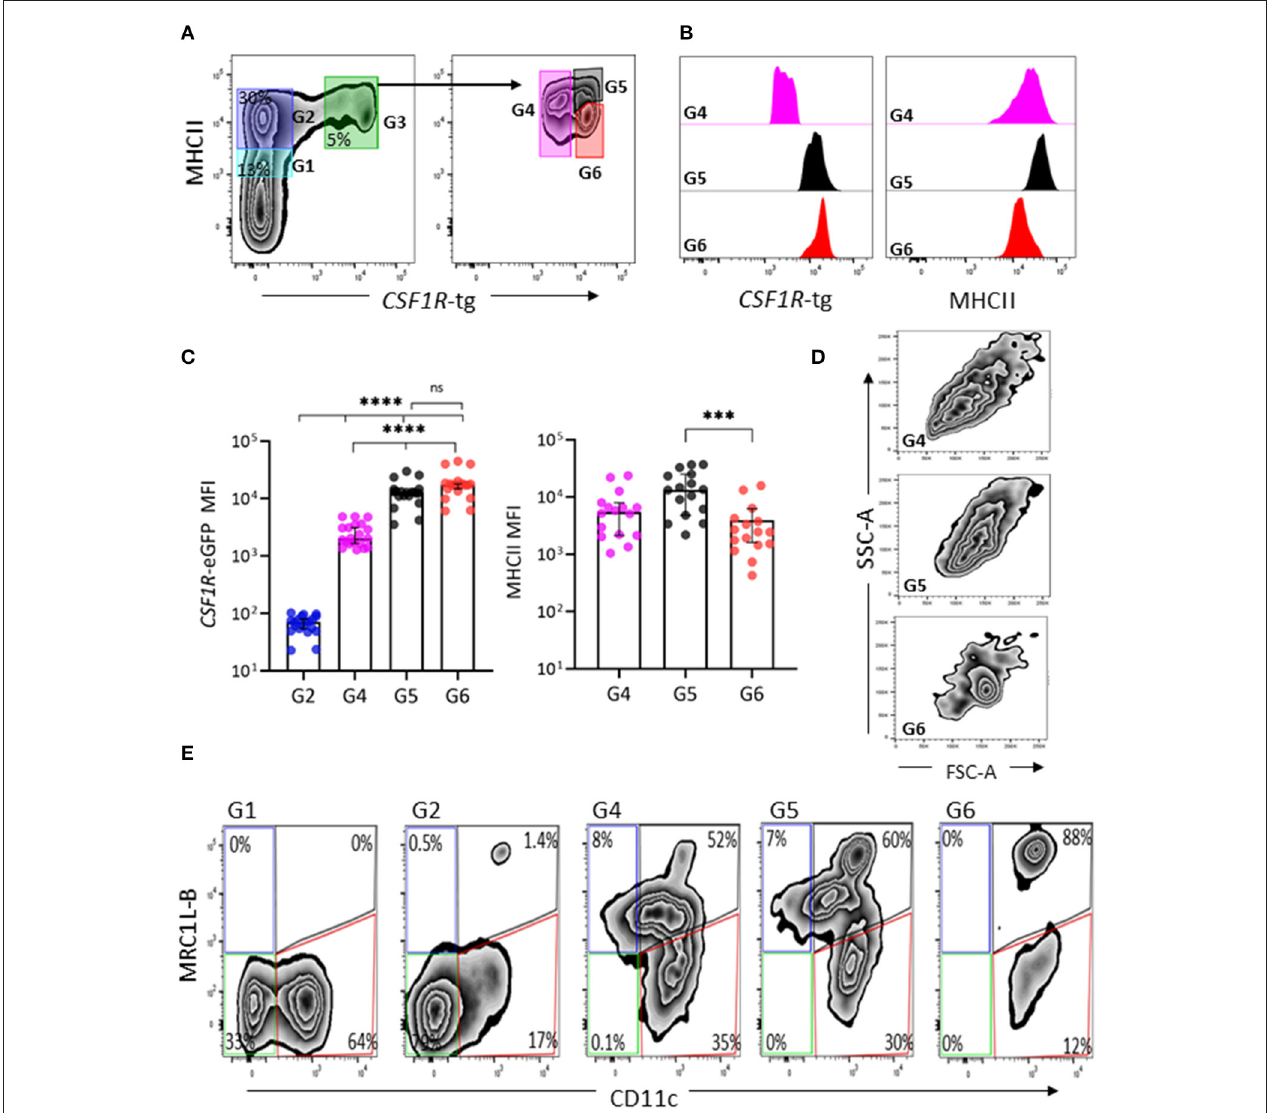
FIGURE 3 | CSF1R -tg and MHCII are diversely expressed by CSF1R -tg + cells. Splenic live, single cells could be separated based on their diverse CSF1R -tg and MHCII expression by flow cytometry. (A) The CSF1R -tg negative populations were gated into MHCII dim [Gate (G1)] and MHCII hi (G2) subpopulations. By applying a gate to the CSF1R -tg + population (G3), the differential expression of the transgene and MHCII could be observed. Three CSF1R -tg + subpopulations were separated into CSF1R -tg dim MHCII inter − hi (G4) and two CSF1R -tg hi cell subpopulations; CSF1R -tg hi MHCII hi (G5) and CSF1R -tg hi MHCIIinter (G6) subpopulations; (B) Representative histograms of CSF1R -tg and MHCII expression levels in the CSF1R -tg + subpopulations (G4-6); (C) The median fluorescent intensity (MFI) analysis across 20 CSF1R -eGFP chickens shows the consistent difference of CSF1R -tg and MHCII expression. Error bars indicate 95% confidence intervals, Asterisks indicate statistical significance ( P < 0.05); (D) The CSF1R -tg hi MHCII inter subpopulation has more uniformed cell size and granularity pattern compared to the CSF1R -tg dim MHCII inter − hi (G4) and CSF1R -tg hi MHCII hi (G5) subpopulations; (E) CSF1R -tg hi MHCII inter (G6) subpopulation has more uniformed expression of MRC1L-B and CD11c compared to the CSF1R -tg dim MHCII inter − hi (G4) and CSF1R -tg hi MHCII hi (G5) subpopulations. Analysis were applied to cells gated based on size/granularity, live, single cells, CSF1R -tg + MHCII + gates using FMO-1 controls. Data is representative of 5 or more independent experiments from 4-8 week old CSF1R -eGFP transgenic chickens.